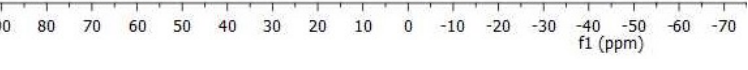
Figure 7. FT-IR spectrum of the product (red line) and the substrates 1,1,1,3,5,5,5- heptamethyltrisiloxane (yellow line) and allyl polyether (blue line). The presence of this band in the spectrum, along with the disappearance of the bands at 2100 and 903 cm − 1 assigned to the stretching vibrations of Si–H group present in the spectra of the substrate, testify to the formation of the product of hydrosilylation and not condensation of Si–H and